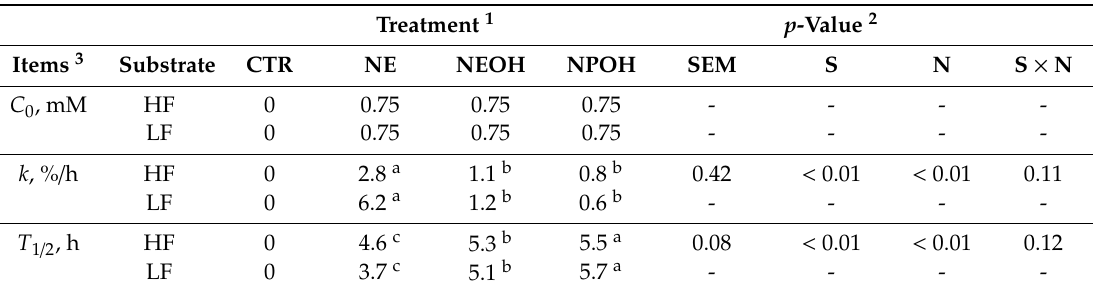
Table 3. The disappearance kinetics of nitrocompounds during in vitro ruminal fermentation of substrates with a high (HF) and low (LF) forage content incubated in batch cultures of mixed rumen microorganisms.